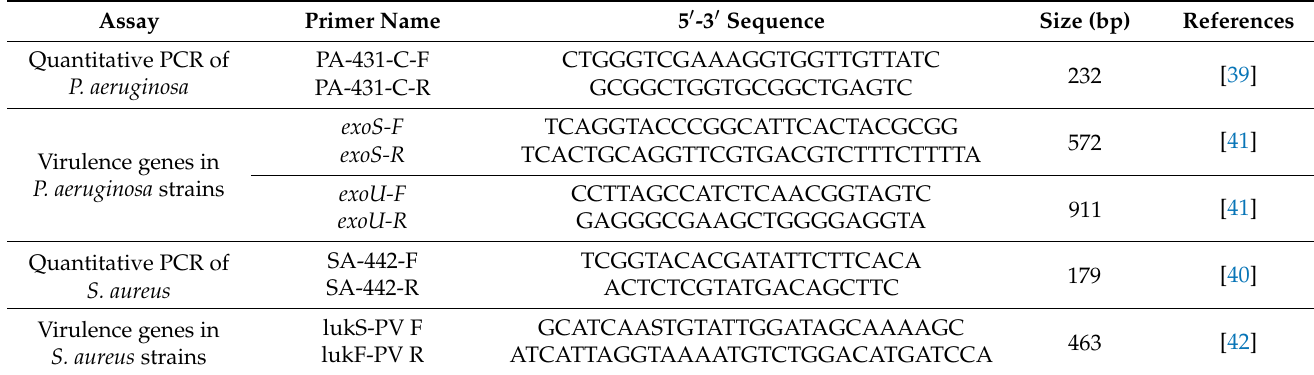
Table 3. Primers used in polymerase chain